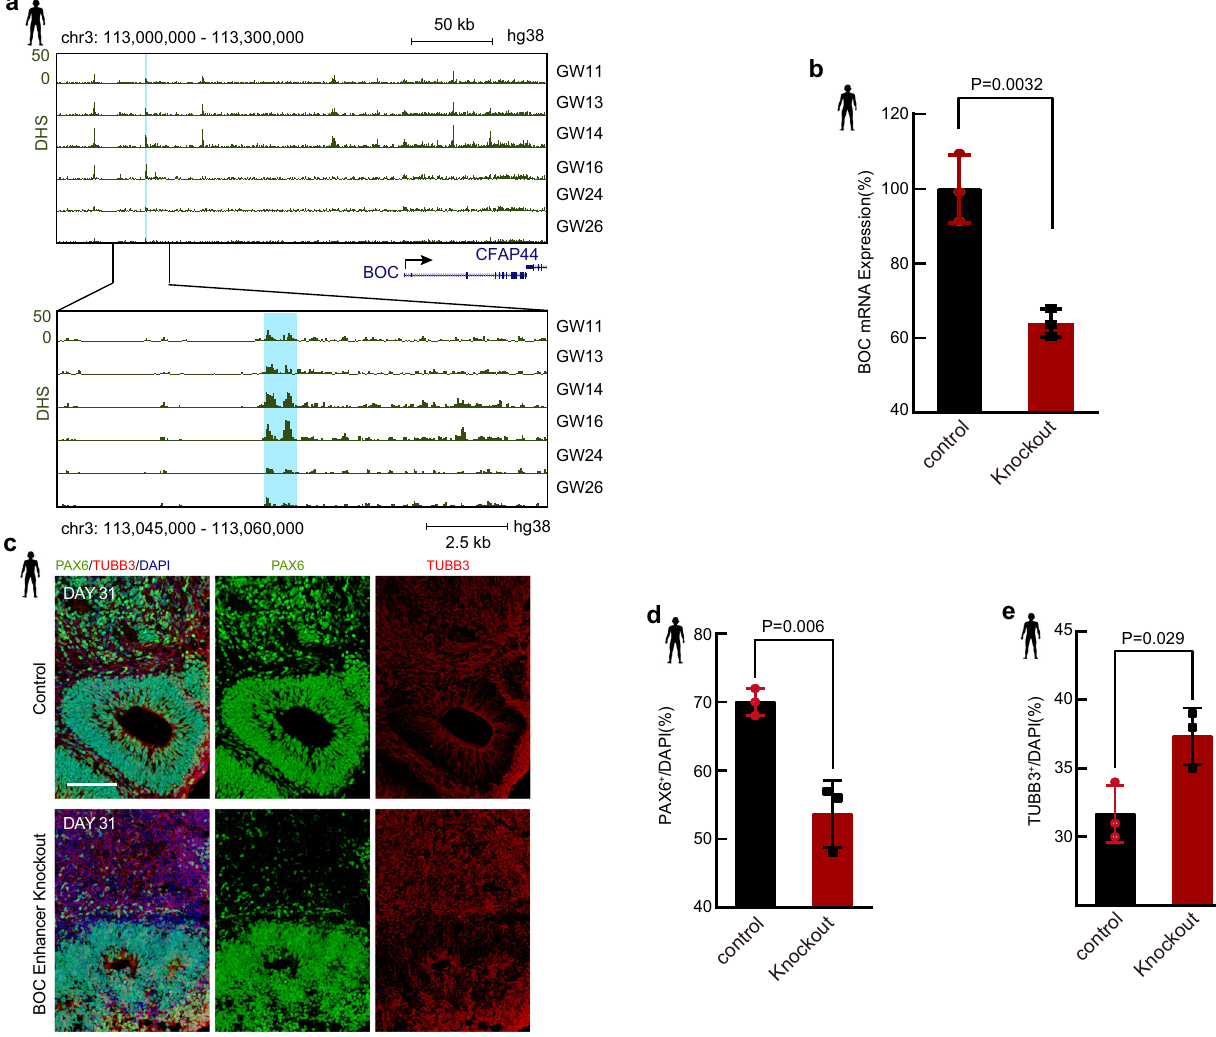
Fig. 3 Function of the paired regulatory element on BOC in human cortical organoids. a Genome browser view of the chromatin accessibility signal around the BOC gene during human PFC development. The black arrow indicates the direction of BOC transcription. The light blue shadow marks an upstream enhancer of BOC . b The expression levels of BOC in BOC enhancer knockout and control human cortical organoids. Student ’ s t test with a two- sided model was used for statistical analysis. n = 3 independent replicates. The error bars were de fi ned as the mean values± SD (standard deviation). c Immunostaining for PAX6/TUBB3/DAPI in human cortical organoids at developmental day 31. Scale bar, 50 μ m. Representative images are shown from n = 3 independent replicates. d The percentage of PAX6 + neuron progenitor cells in control and BOC enhancer knockout human cortical organoids. Student ’ s t test with a two-sided model was used for statistical analysis. n = 3 independent replicates. The error bars were de fi ned as the mean values ± SD. e The percentage of TUBB3 + mature neurons in control and BOC enhancer knockout human cortical organoids. Student ’ s t test with a two-sided model was used for statistical analysis. n = 3 independent replicates. The error bars were de fi ned as the mean values ±